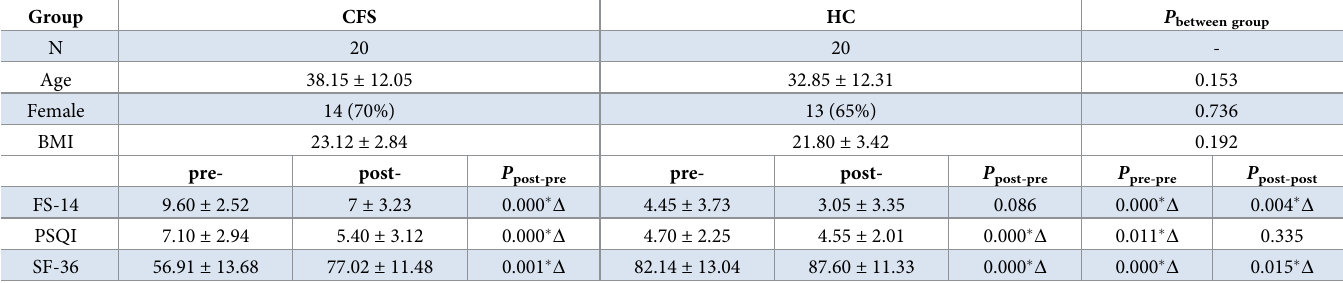
Table 1. Demographics and clinical measurements (mean ±